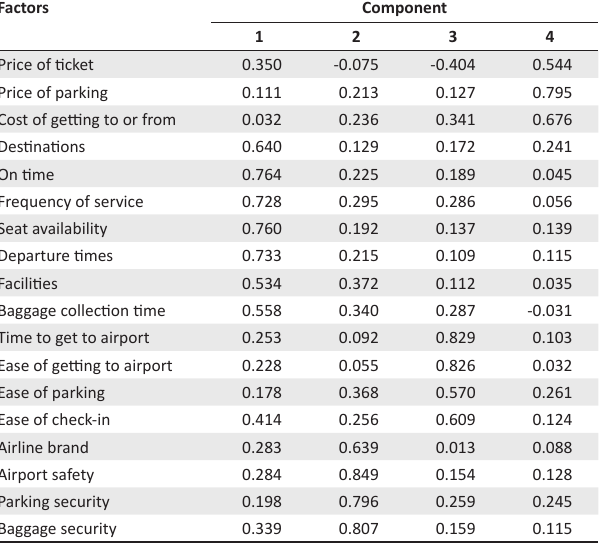
TABLE 9: Factor structure (rotated) – 2013 data. Factors